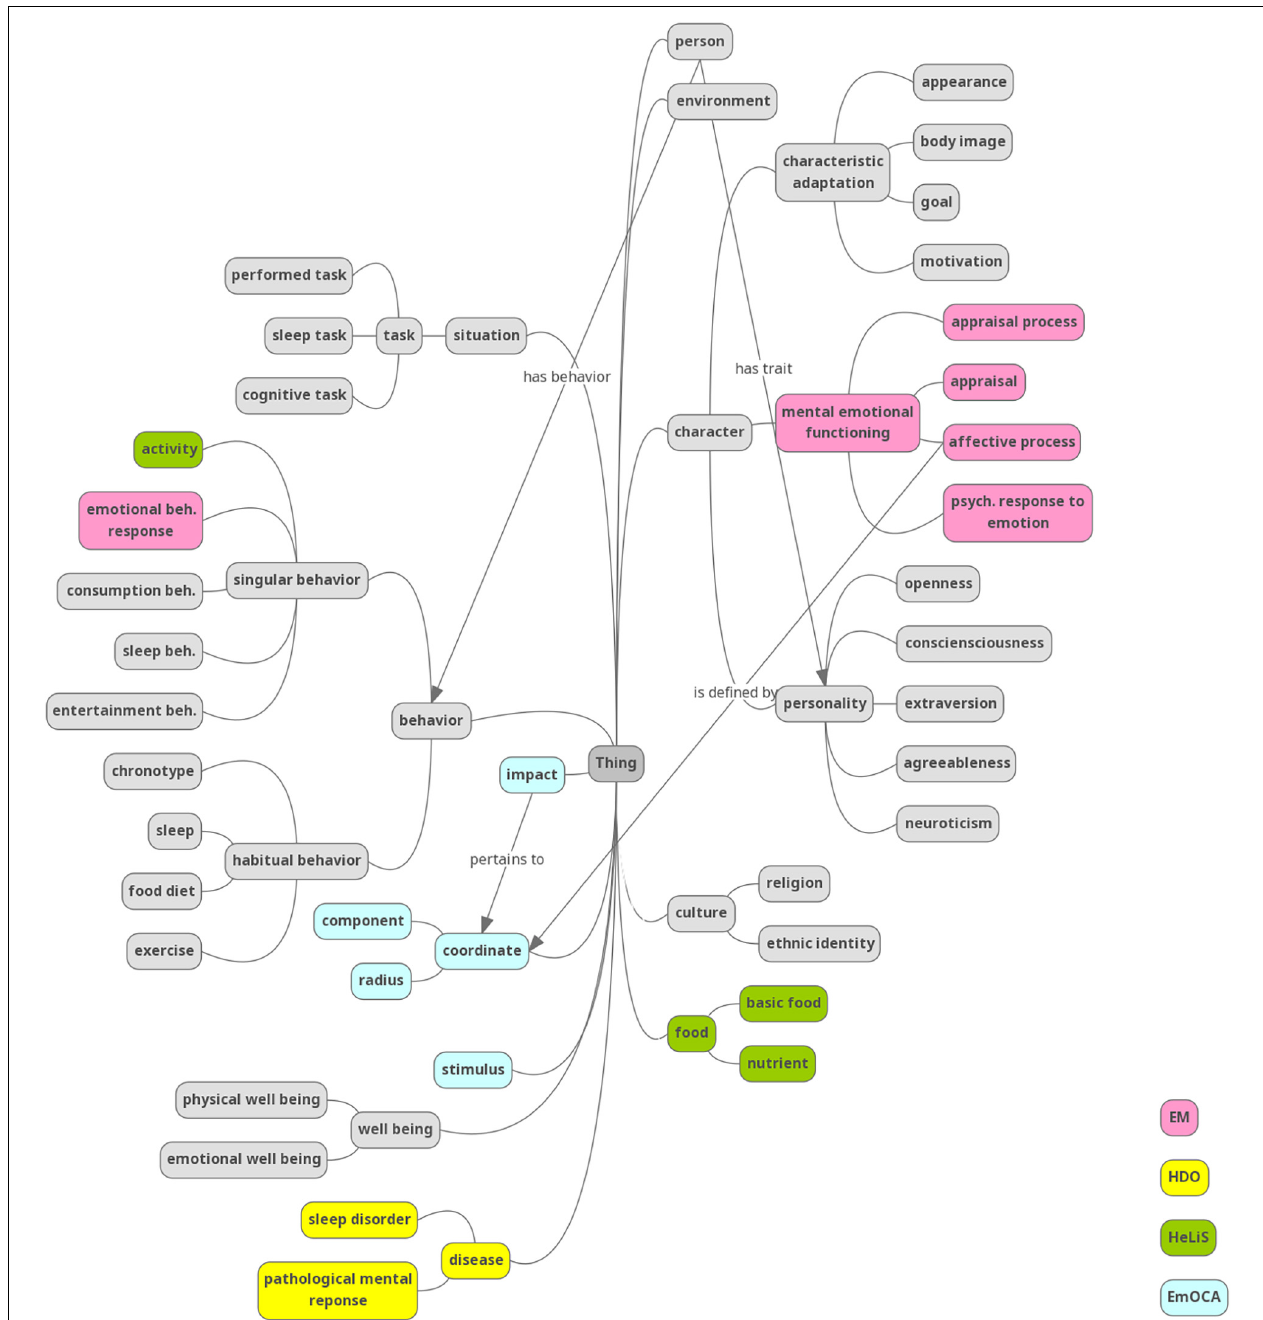
FIGURE 3 | An overview of the hierarchy of CCOnto (in gray) and the main integrated concepts. Unlabeled arrows represent a relations.